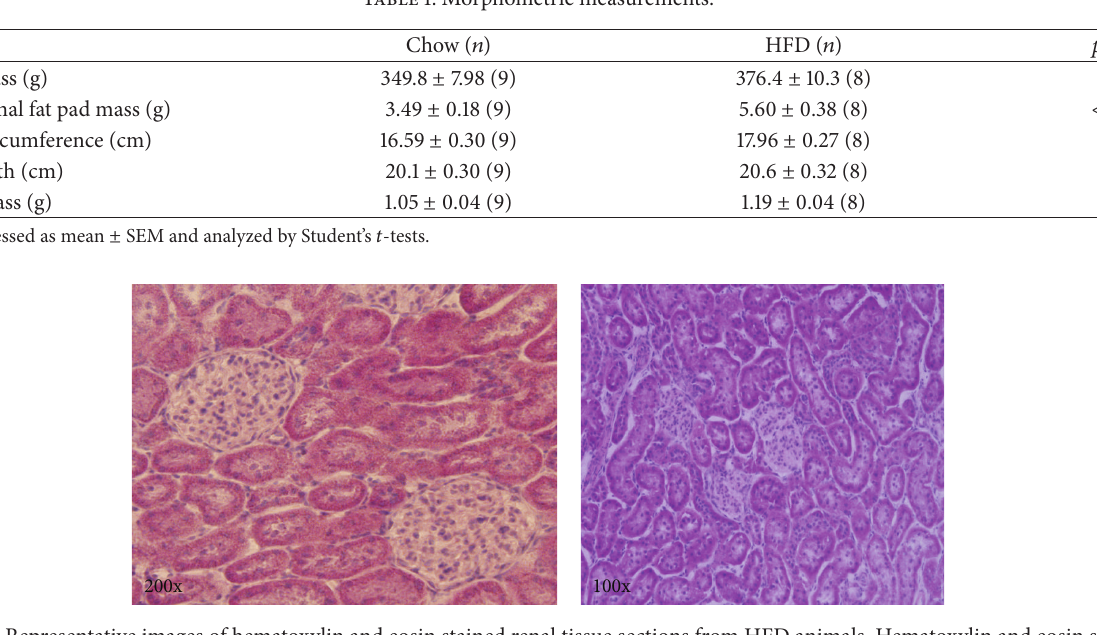
Table 1: Morphometric measurements.